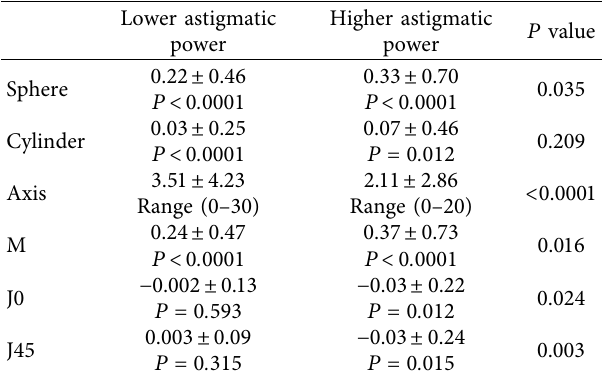
Table 1: Comparison of mean differences of sphere, power, axis, M, J0, and J45 before and after cycloplegia in different cylindrical power